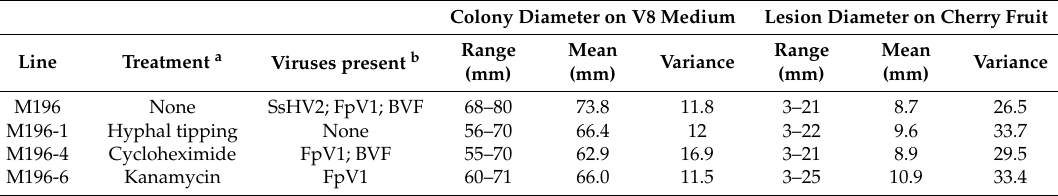
Table 2. Summary of colony diameter on V8 medium and lesion diameter on cherry of isogenic M. fructicola